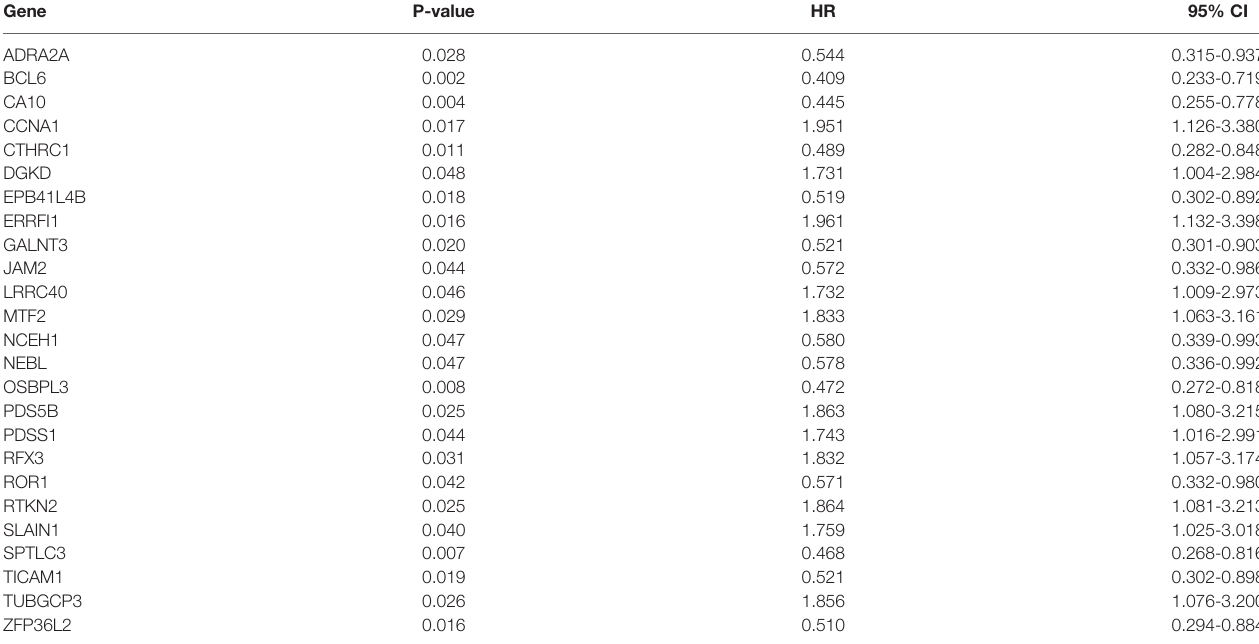
TABLE 1 | The 25 genes related to overall survival according to Kaplan – Meier survival analysis. Gene P-value HR 95% CI